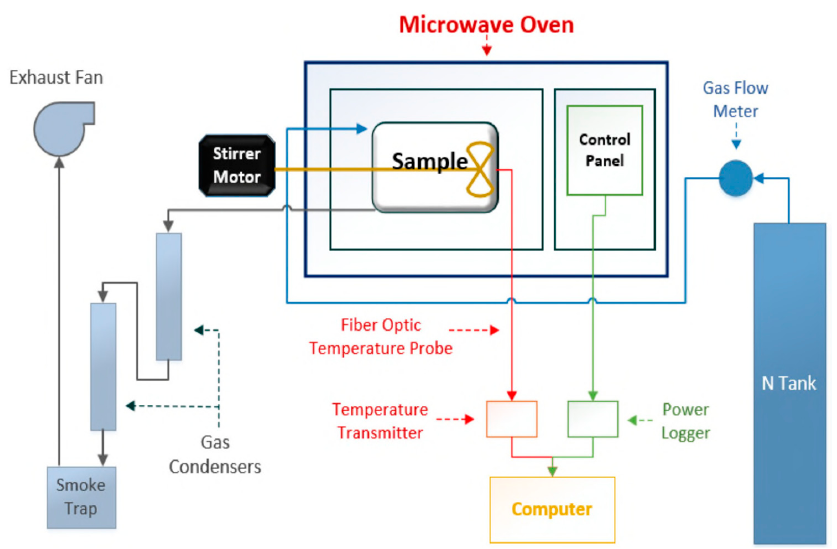
Figure 2. Schematic diagram of the microwave-assisted torrefaction pretreatment setup. Extracted from [21].